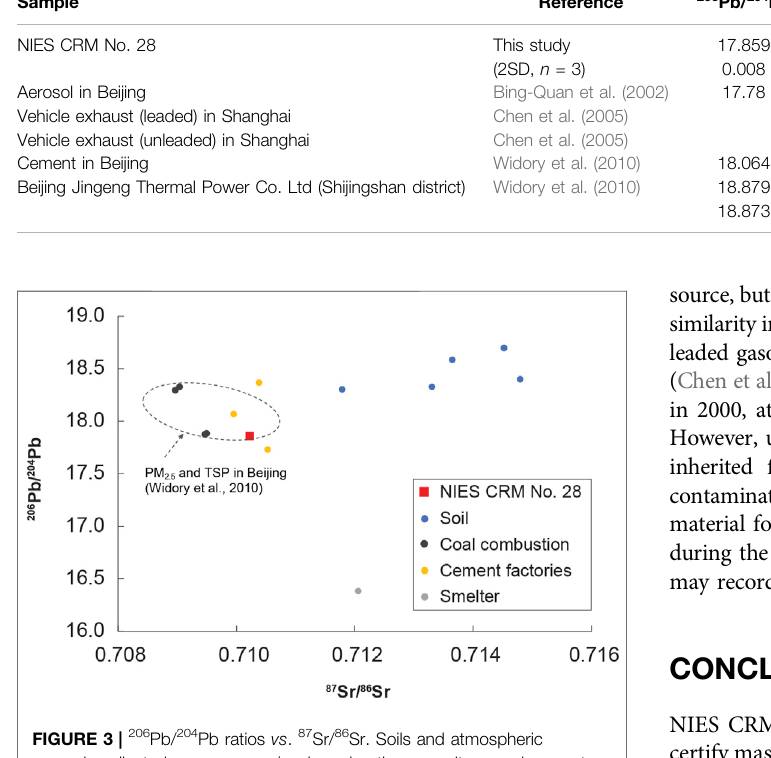
14 ppm (2SD, n (cid:1) 4), and 0.8616 ± 0.278 and 21 ± 16 ppm (2SD,